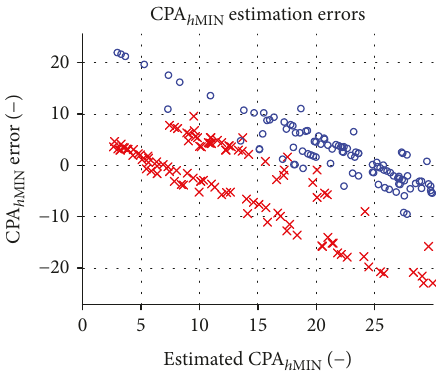
Figure 14: Estimation errors of 3D horizontal CPA (red x: close encounters; blue circle: far encounters).